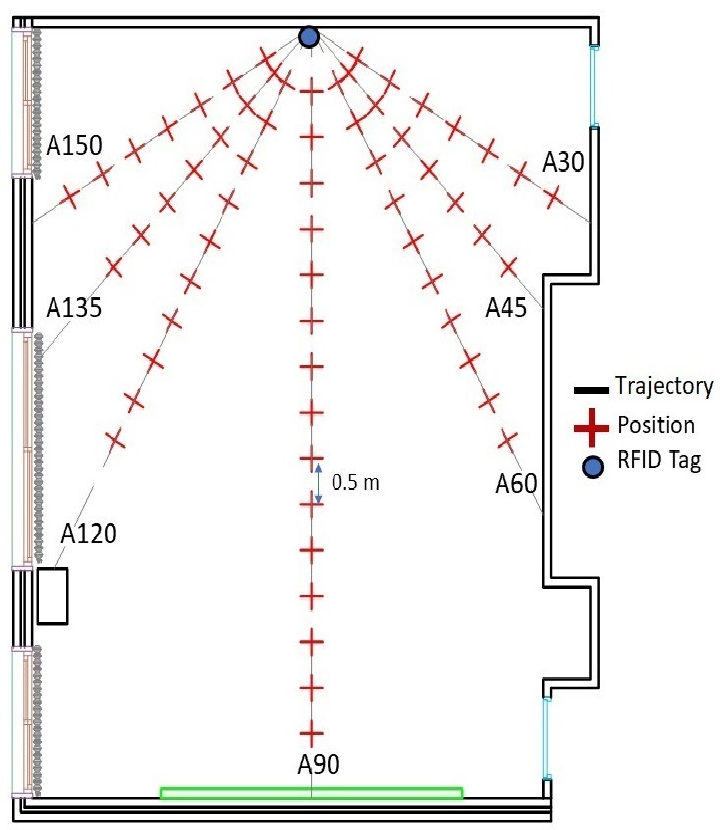
Figure 8. Auto-fingerprint map.